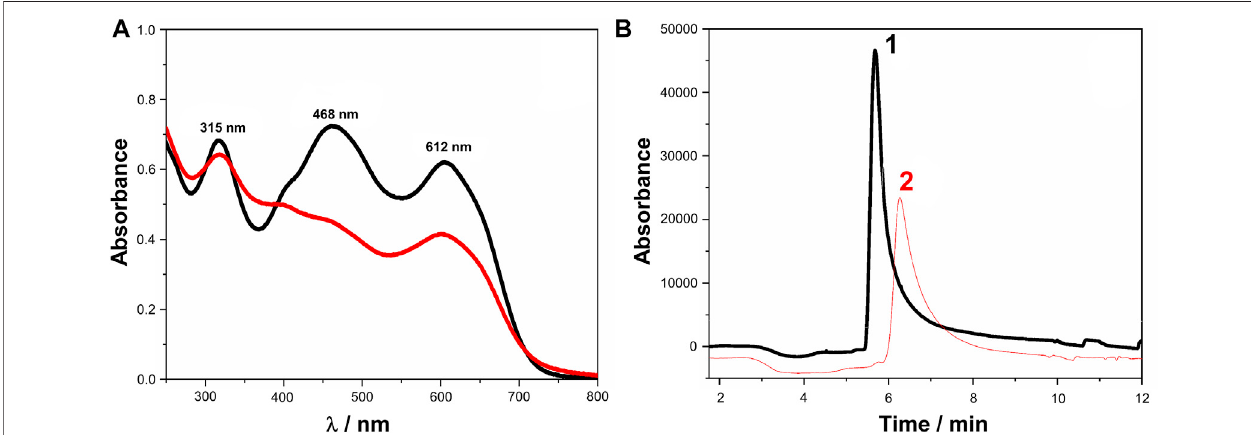
FIGURE 2 | (A) UV-Vis spectra and (B) HPLC-DAD chromatograms obtained for 50 mg L − 1 of AB210 fresh solution (black line) and exposed to room ambient for 14 days (red line), respectively. Mobile phase: ACN/H 2 O (1:1, v/v). T = 30 ° C, fl ow rate = 0.5 ml min − 1 . Detection: λ = 612